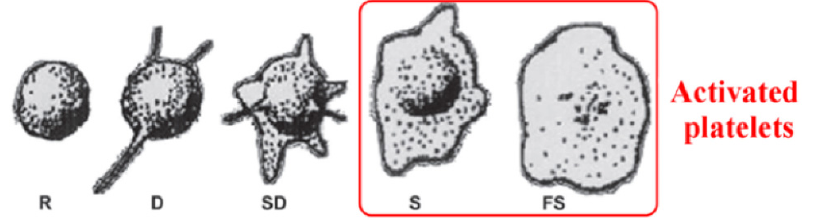
Figure 3. copyright 2014 American Chemical Society. Figure 3. Copyright 2014 American Chemical